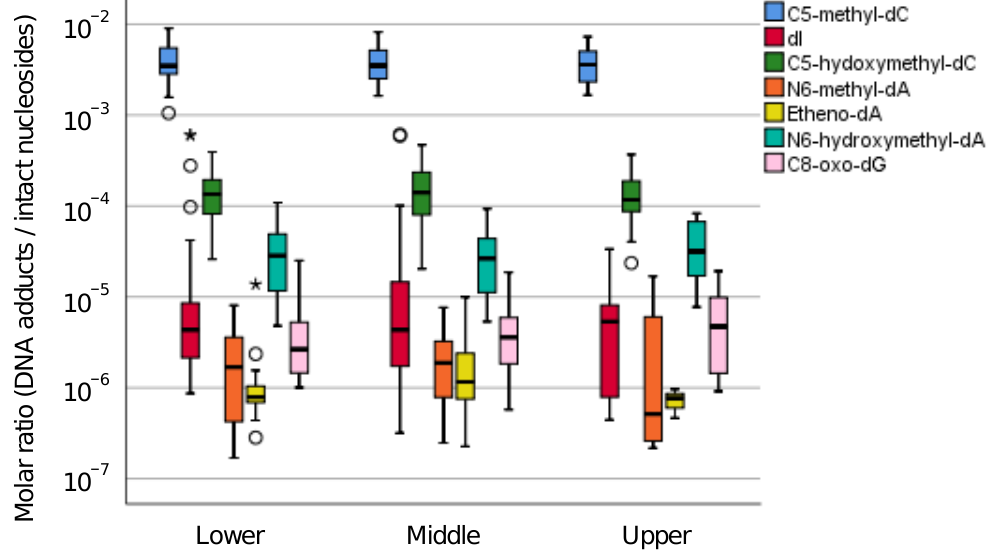
Figure 2. Distribution of DNA adduct profiles in the upper, middle, and lower parts of the gastric mucosae of gastric cancer patients. The molar ratio data of DNA adducts were retrieved from our previously published research [57]. The center line of the box indicates the median, and the top and bottom edges of the box indicate their interquartile ranges (IQR). The whiskers show the maximum or minimum values within a range of 1.5 times the IQR from the edge of the box. Outliers are indicated by circles ( ◦ ) that are 1.5 to 3 times the IQR from the top or the bottom of a box and by stars (*) that are more than 3 times the IQR from the top or the bottom of a box.